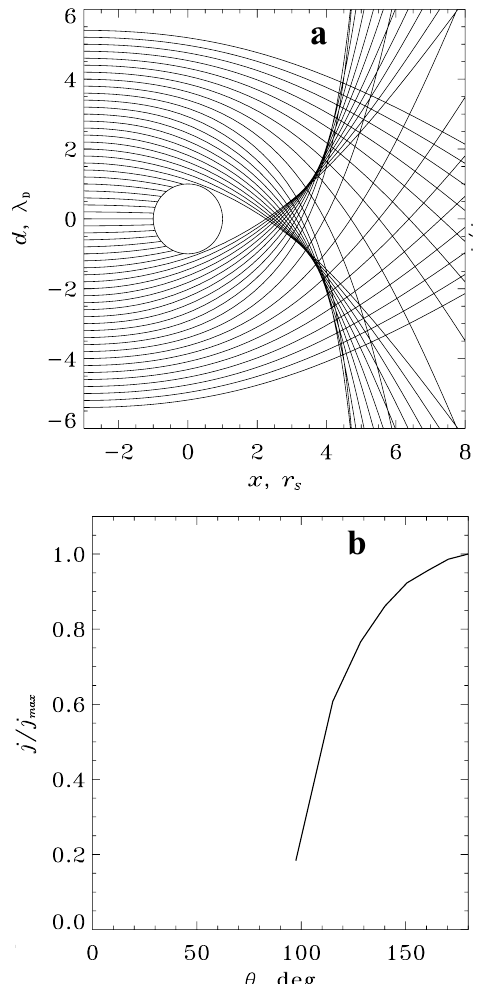
Fig. 9. (a) Trajectories of H + ions and (b) corresponding current angular distribution over the probe surface. Conditions are identical to those in Fig.